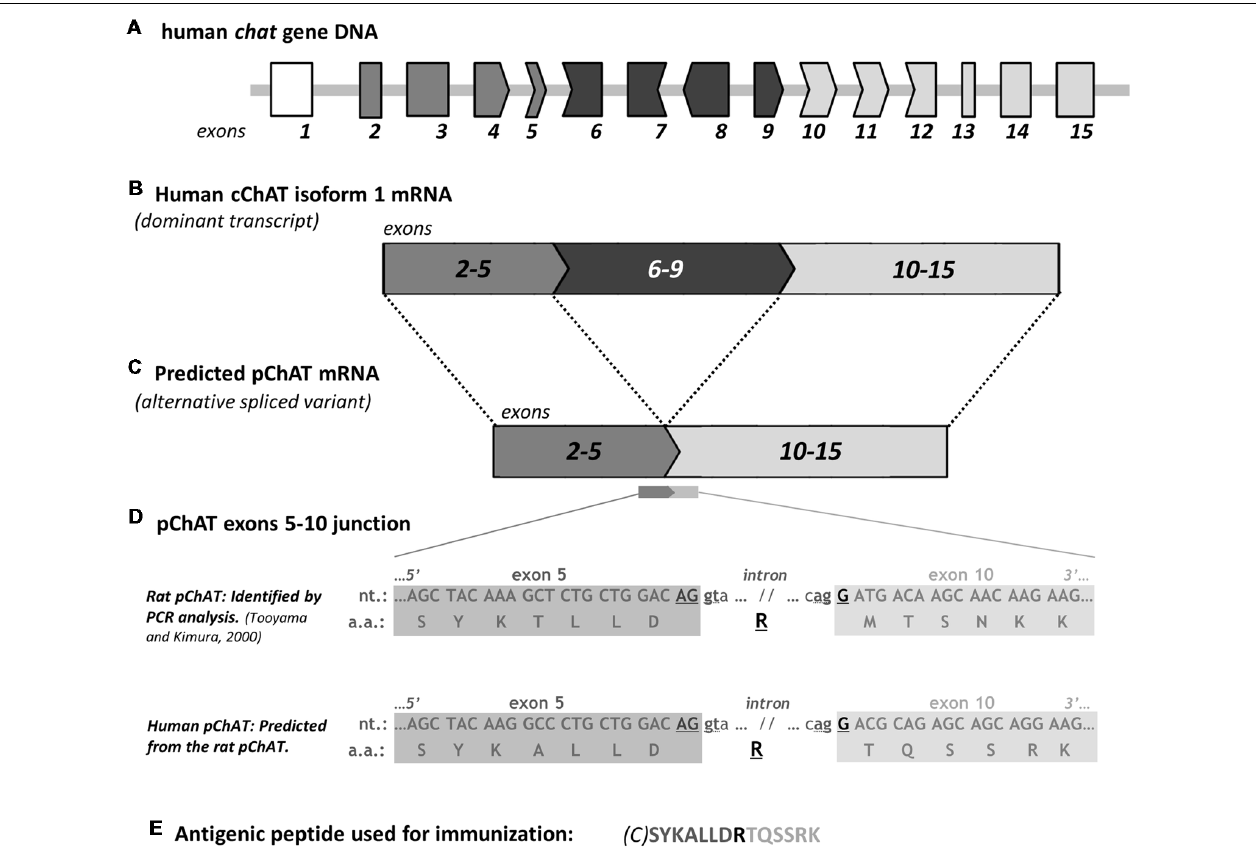
FIGURE 1 | A schematic diagram for predicting human peripheral choline acetyltransferase (pChAT). The human chat gene contains 15 exons (A) . Some of these exons have nucleotides base residues; one or two bases at 3’-end of an exon and two or one base at 5’-end of the following exon. Across the alternative splice junction between two such exons, three bases joined to encode an amino acid. As to nucleotide residues, six types of exon are shown in (A) with respective shapes of their enclosing frames; type 1 (no residue; exons 2, 3 and 13–15), type 2 (two residues at 3’-end; exons 4 and 9), type 3 (one residue at 5’-end plus 2 residues at 3’-end; exons 5, 10 and 11), type 4 (one residue at 5’-end; exons 6 and 12), type 5 (one residue at 3’-end; exon 7), and type 6 (two residues at 5’-end; exon 8). By full-length alternative splicing of exons 2–14, common ChAT (cChAT) isoform 1 mRNA is formed (B) . In the rat, a similar framework has been found regarding both chat gene and cChAT mRNA splicing. We have therefore predicted the alternative splicing for human pChAT (hpChAT) mRNA, which is encoded in 10 exons (C) , produced by four-exons skipping (exons 6–9), in a similar way to that identified in rat (Tooyama and Kimura, 2000). The difference in nucleotide sequence at the spliced junction of exon 5 and exon 10 between rat and human is shown in (D) . In the rat, arginine (R) is encoded by three nucleotides across the splice junction; two (AG) from the 3’ end of exon 5 and one (G) from 5’ end of exon 10. In human, arginine (R) is incidentally also formed in exactly the same way. There are amino acids encoded similarly by two spliced exons, six in cChAT and four in predicted pChAT of both rat and human, as defined or predicted on the basis of two databases (“amino acids encoded across a splice junction” in NCBI CCDS database release 22, and “residue overlap splice site” in Ensembl database release 94). Note the two sets of two nucleotides, “gt” at the 5’ end of the intron after exon 5 and “ag” at the 3’ end of the intron before exon 10, which appear to serve as the splice donor and acceptor sites, respectively. Thanks to this splicing machinery, parts of the original cChAT reading frame are perfectly retained in pChAT. The peptide sequence used as an antigen for raising hpChAT is shown in (E) , where C in parenthesis is extra added cysteine for conjugation with a carrier protein. For simplification, other three upstream exons coding for the larger cChAT isoform 3 and vesicular acetylcholine (ACh) transporter are omitted from the human chat gene in the diagram presented. nt, nucleotides; a.a. amino